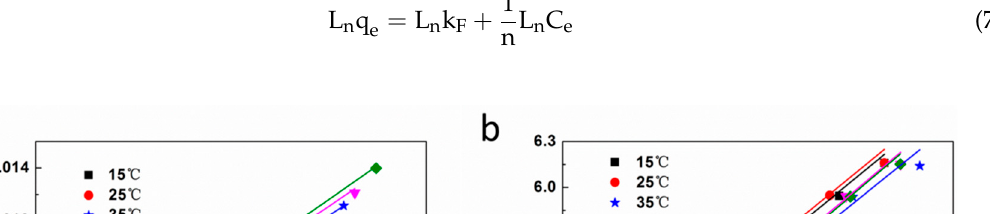
Table 2. Adsorption isotherm parameters for MB adsorption of CNC-g-AA aerogels. Langmuir